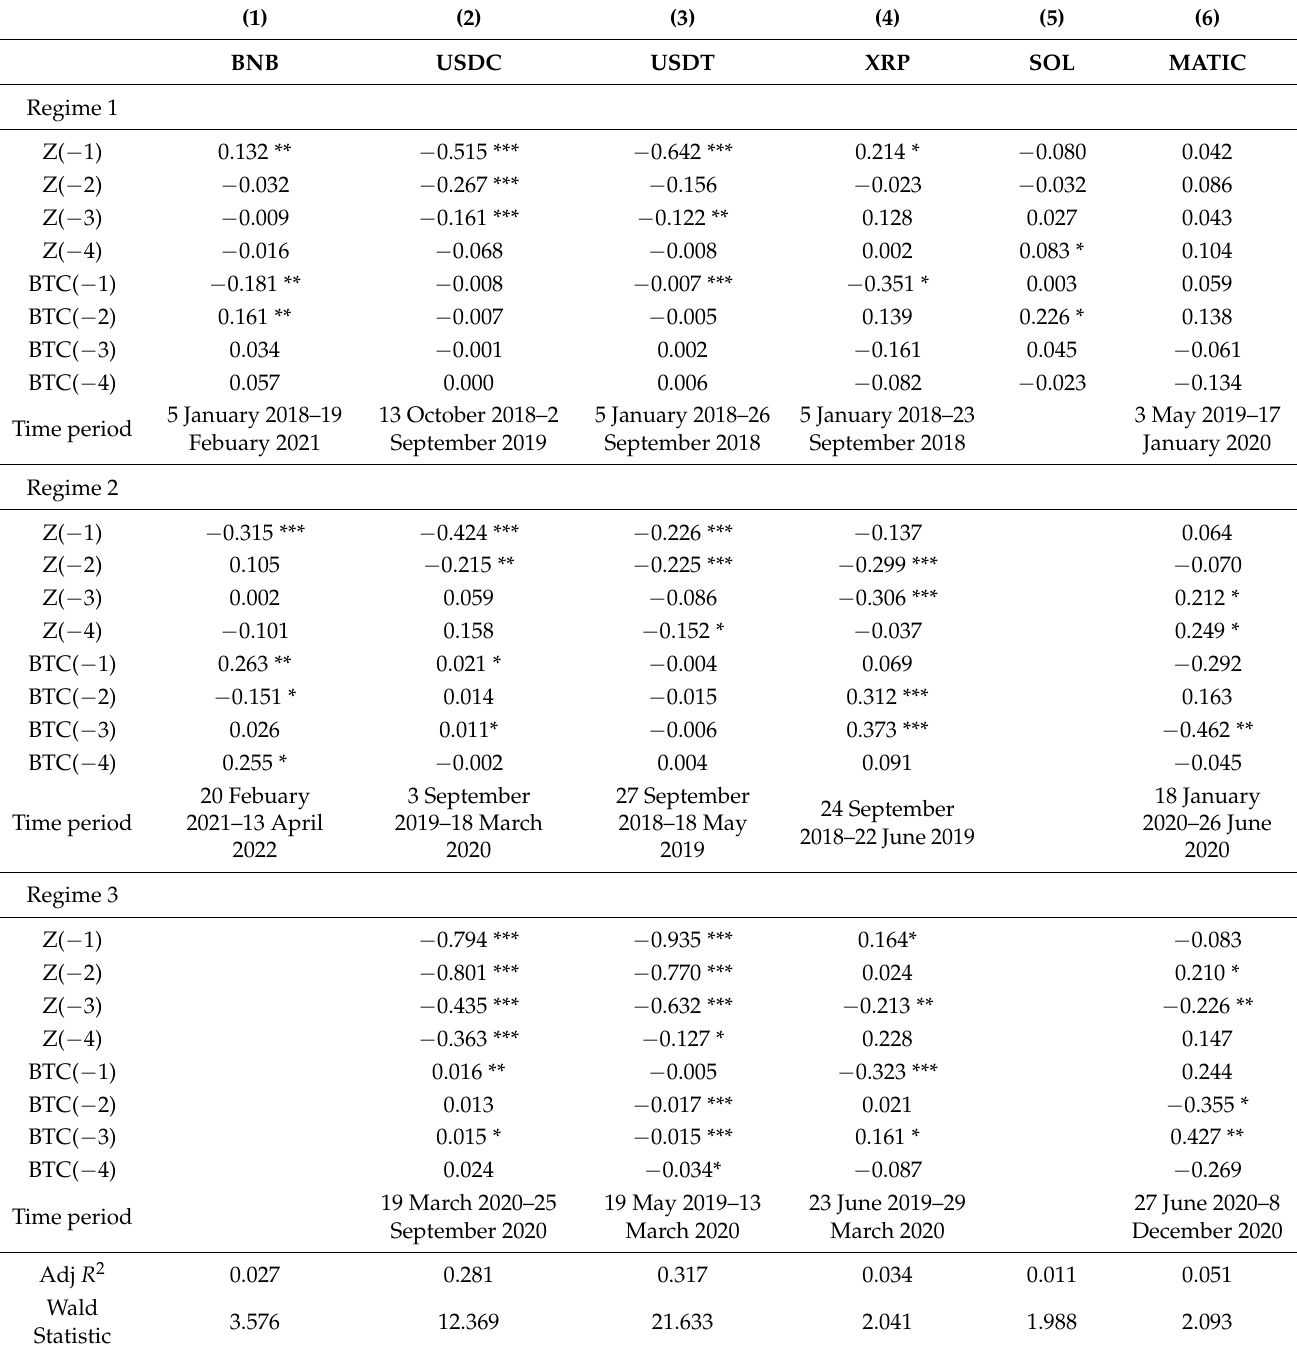
Table 2. The in-sample results for one-step-ahead forecasting with